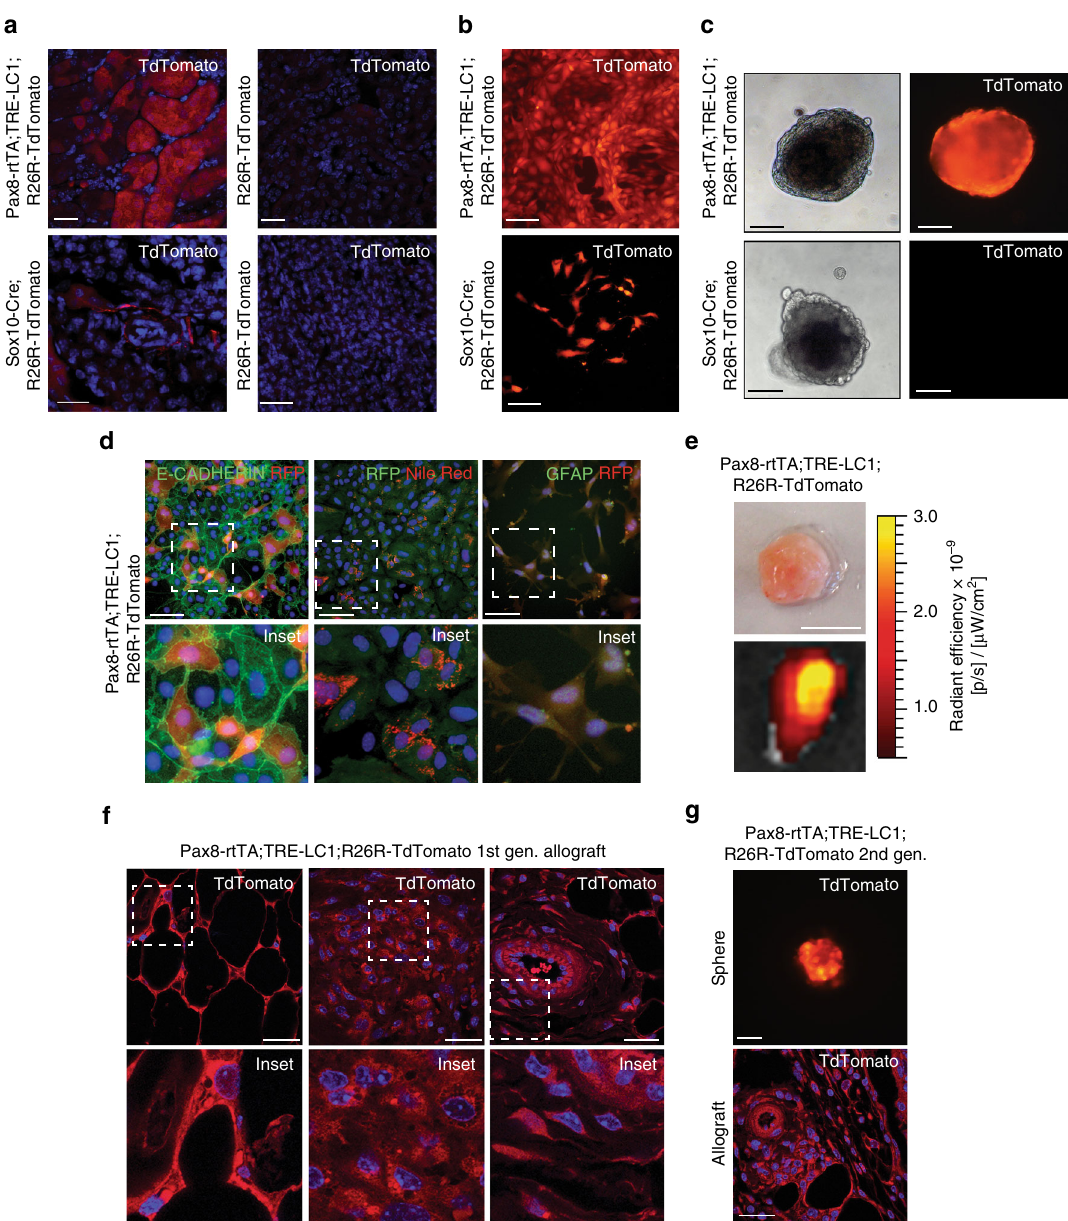
Fig. 4 Engineered renal AML-like tumours derive from renal epithelial cells. a Fluorescence images of kidney tissue from doxycycline-treated Pax8-rtTA;TRE- LC1;R26R-td Tomato mice and from Sox10-Cre;R26R-td Tomato mice and respective controls. Scale bars: 50 μ m. b Images of primary kidney cells isolated from doxycycline-treated Pax8-rtTA;TRE-LC1;R26R-td Tomato mice and from Sox10-Cre R26R-td Tomato mice. Scale bars: 50 μ m. c Red fl uorescence signals in spheres derived from infection of cultures in b with shRNA- Tsc2 + Cdkn2a lentivirus. Scale bars: 50 μ m. d Differentiation of Pax8-td Tomato positive spheres into epithelial cells (E-CADHERIN immuno fl uorescence), adipocytes (Nile Red staining) and glial cells (GFAP immuno fl uorescence). tdTomato was detected using an anti-RFP antibody. Scale bars: 50 μ m. e tdTomato-positive shRNA- Tsc2 + Cdkn2a allograft derived from Pax8-rtTA;TRE-LC1;R26R-td Tomato spheres. Scale bars: 1cm. f Representative red fl uorescence in histological sections of shRNA- Tsc2 + Cdkn2a allografts derived from Pax8-rtTA;TRE-LC1;R26R-td Tomato mice: DAPI and td Tomato overlay. Scale bars: 50 μ m. Lower panels represent zooms of the boxed regions in the upper panels. g Example of second- generation shRNA- Tsc2 + Cdkn2a td Tomato positive sphere and allograft histological section derived from a primary shRNA- Tsc2 + Cdkn2a allograft that originated from a Pax8-rtTA;TRE-LC1;R26R-td Tomato mouse. Scale bars: 50 μ proximal tubules compared with distal tubules, loops of Henle and collecting ducts 30 (Fig. 3b). In contrast, comparison with a cumulated list of 593 genes that are speci fi cally upregulated either in distal tubules, loops of Henleor collecting ducts compared to proximal tubules 30 revealed an overlap of only 7 genes (Fig. 3b). The upregulation of a subset of the identi fi ed proximal tubule-